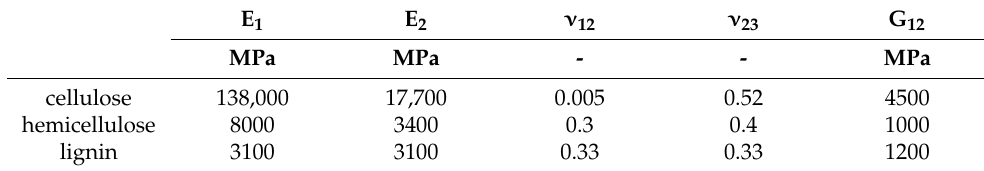
Table 1. Mechanical properties of the base materials of the cell wall single layers.